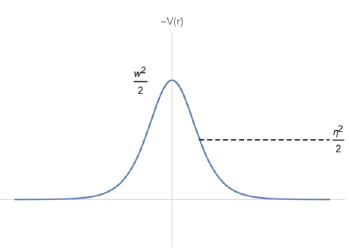
Figure 2. Inverted potential. Restricted to a pure-winding solution θ = − wφ , the cigar equations of motion describe the mechanics of a particle moving in the inverted potential shown. For η real and less than w , there is a real solution that describes a particle that comes in from r → ∞ , rolls partway up the potential hill until it stops at the turning point, and then rolls back out to infinity. The cigar geometry is defined for r ≥ 0 , but to compute the saddle-point expansion of the functional integral we will continue r to the complex plane. Here we draw the potential for the real r